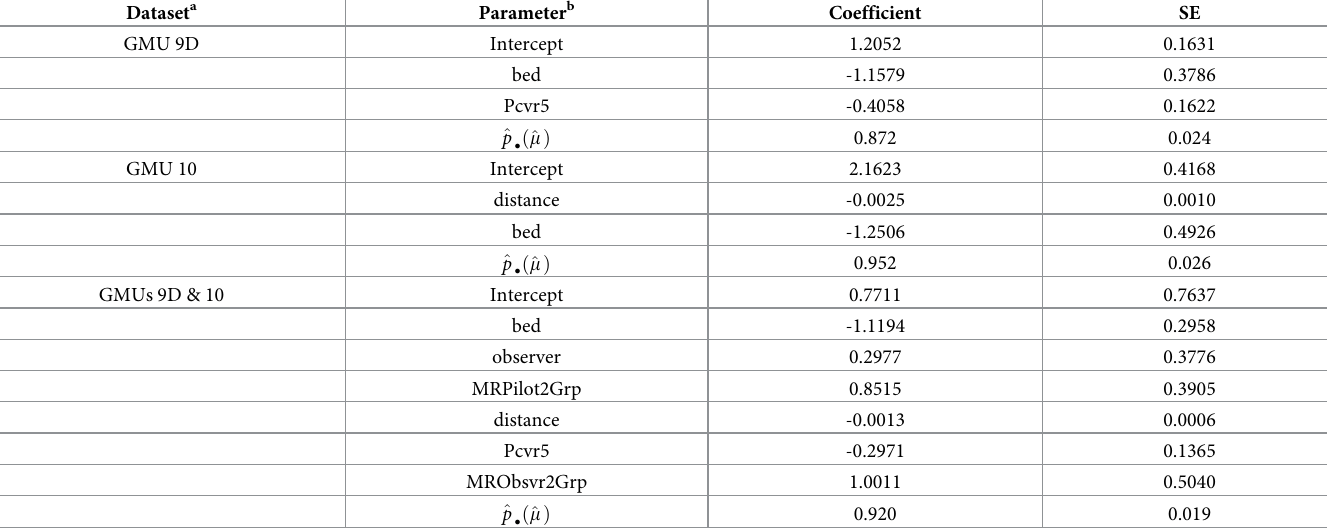
Table 3. Coefficients and standard errors of the best fitting mark-resight (MR) models of bear detections in GMU 9D, GMU 10, and GMU 9D and 10 combined southern Alaska Peninsula, Alaska. Dataset